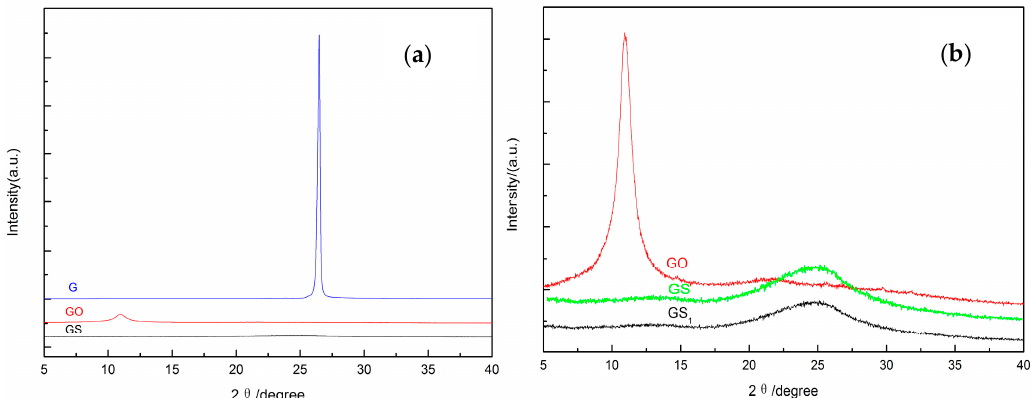
Figure 3. ( a ) X-ray diffraction (XRD) pattern of graphite (G), graphite oxide (GO), and graphene (GS); and ( b ) XRD magnification of GO, graphene (GS1), and GS.